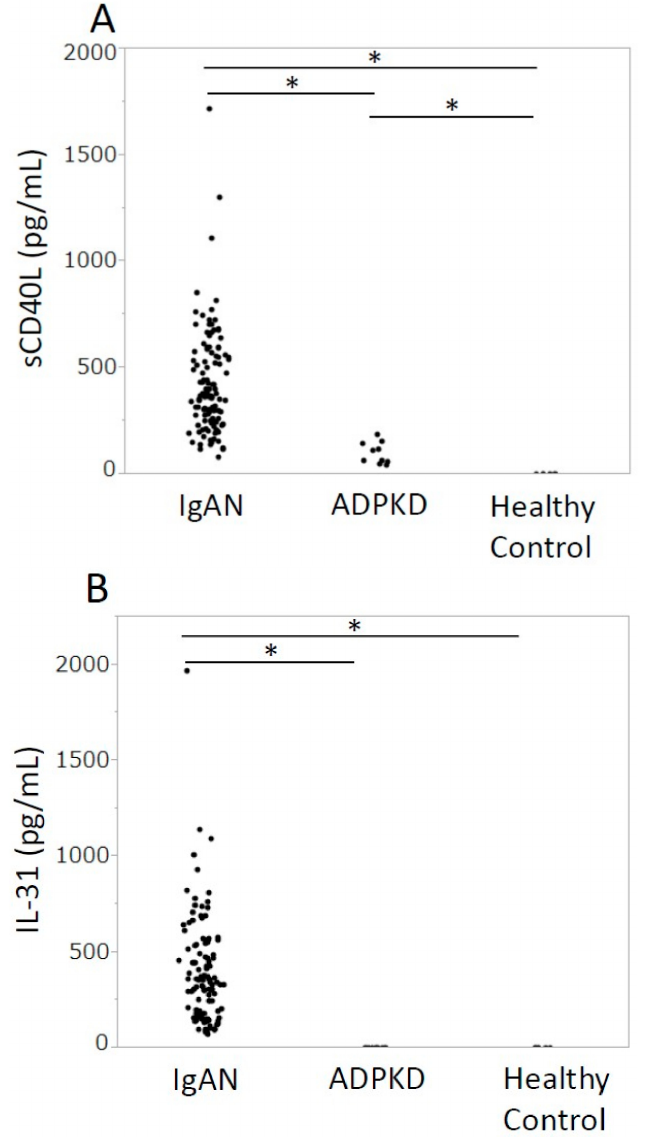
Figure 1. The distribution of serum sCD40L/IL-31 in three groups. The sCD40L ( A ) and IL-31 ( B ) levels in IgAN patients were significantly higher in comparison to ADPKD patients and healthy controls. ADPKD, autosomal dominant polycystic kidney disease; IgAN, IgA nephropathy; IL-31, interleukin 31; sCD40L, soluble CD40 ligand. * p <